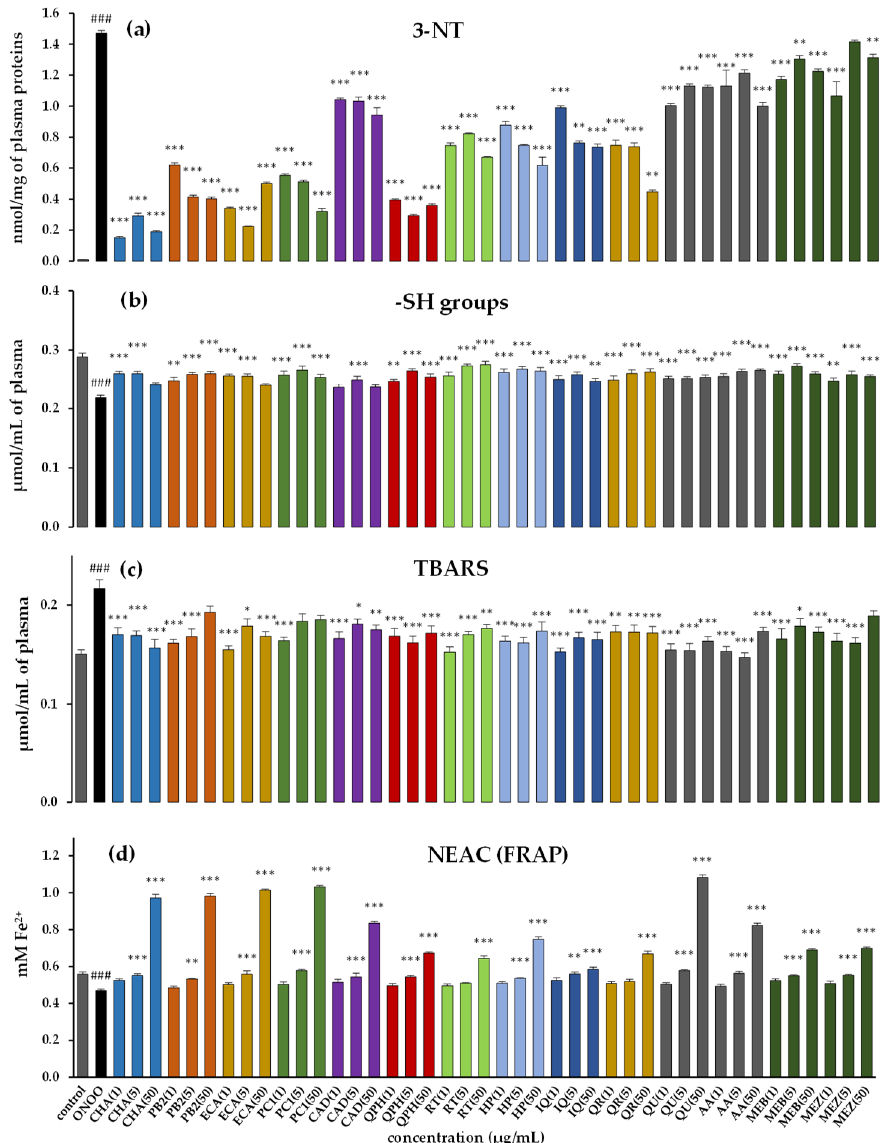
Figure 4. Effects of Cotoneaster phenolics on human plasma exposed to oxidative stress: ( a ) effects on the nitration of tyrosine residues in plasma proteins and formation of 3-NT; ( b ) effects on the oxidation of free -SH groups; ( c ) effects on the peroxidation of plasma lipids and formation of TBARS; ( d ) effects on the non-enzymatic capacity of plasma (NEAC), assessed by the FRAP assay. Results expressed as means ± SE ( n = 8) for repeated measures: ### p < 0.001, for ONOO ‒ -treated plasma (without the analytes) versus control plasma, and *** p < 0.001, ** p < 0.01, * p < 0.05 for plasma treated with ONOO ‒ in the presence of the investigated markers, extracts or standards (1–50 µg/mL) versus ONOO ‒ -treated plasma in the absence of the analytes. For compounds and extract codes, see Figure 1 and Table 2. Positive controls: QU, quercetin; TX, Trolox ® ; AA, ascorbic acid.